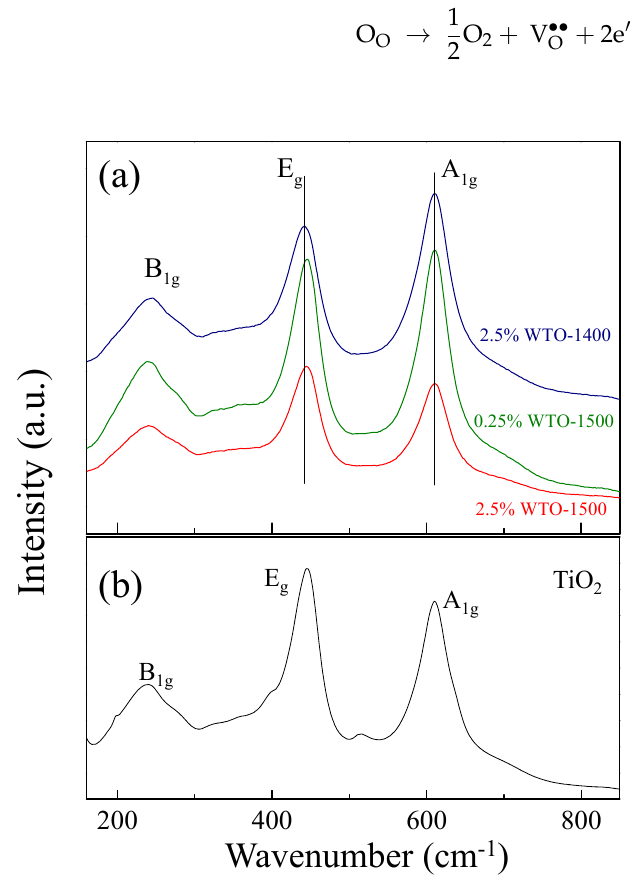
Figure 4. Raman spectra of ( a ) WTO ceramics and ( b ) pure TiO 2 ceramic.